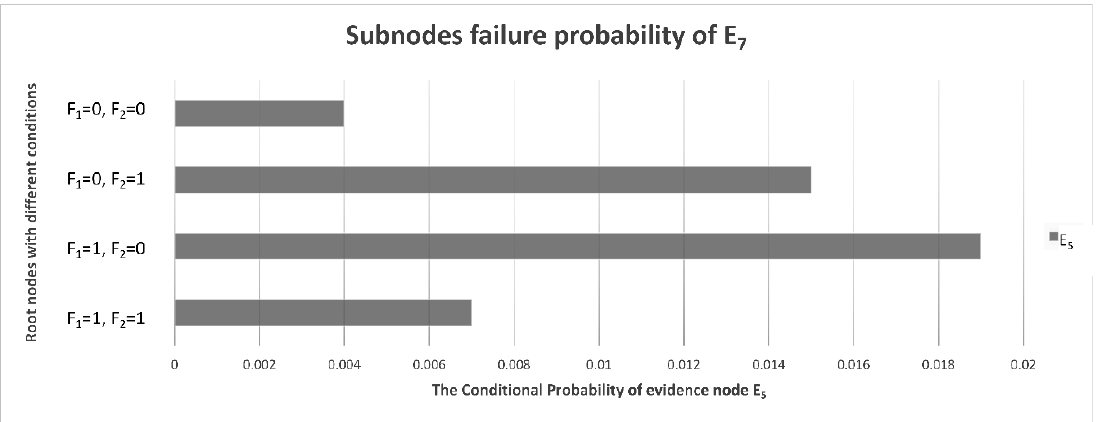
Figure 10. Conditional probability distribution diagram of E 5 ’s sub-nodes.